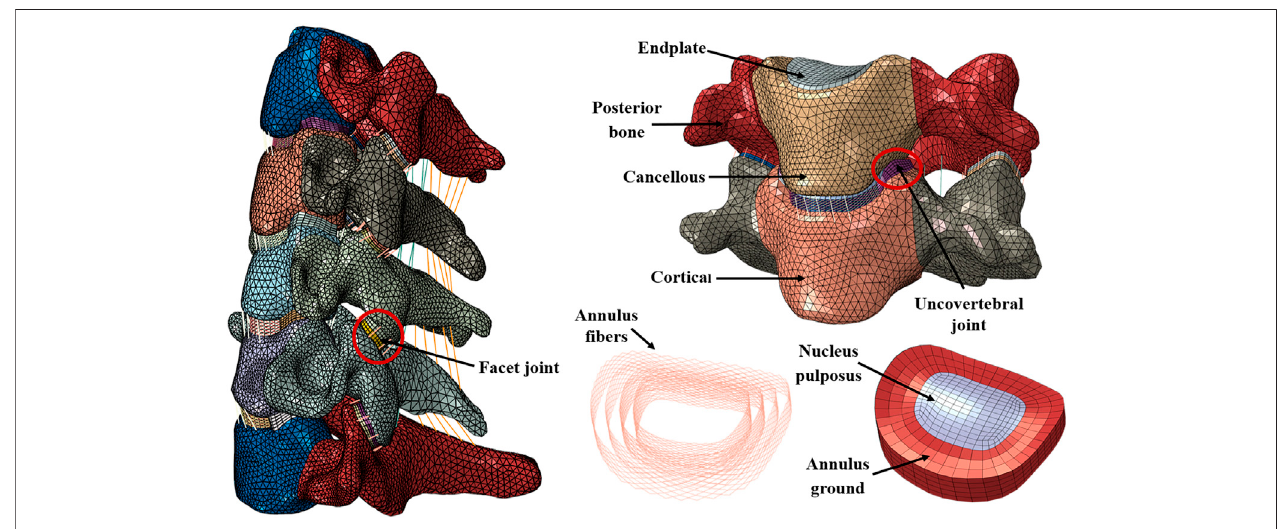
FIGURE 1 | Finite element model of intact C3 – C7 and components.